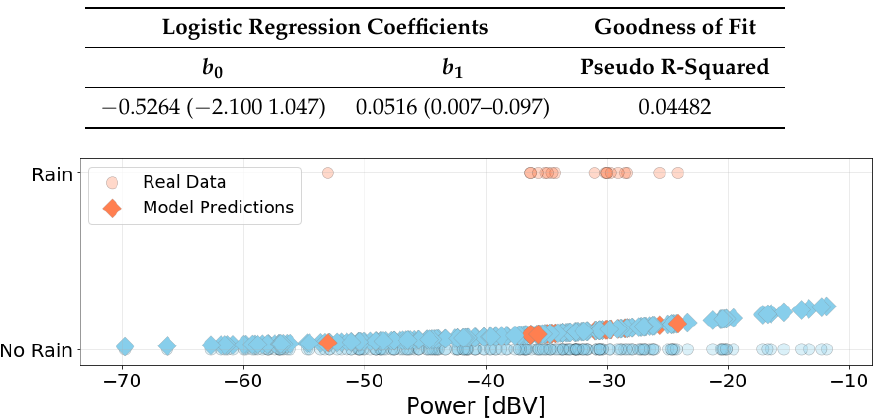
Figure 9. Data grouped by presence of rain and predictions using the logistic